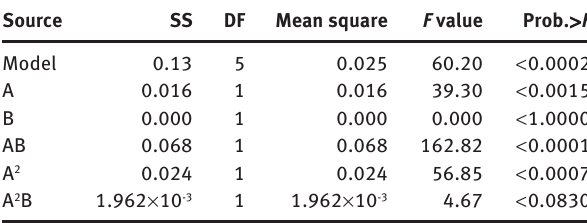
Table 2 ANOVA results for the zeta potential response for regression model equation and coefficients of model